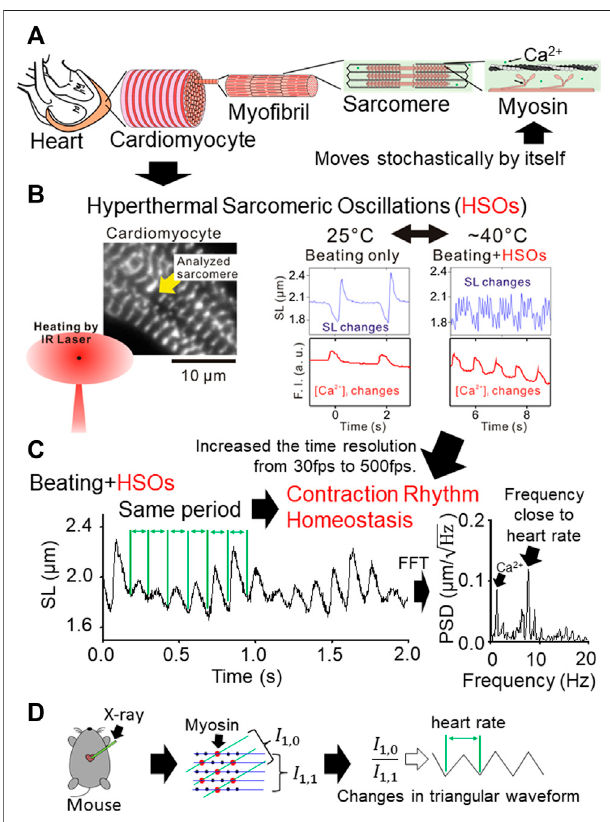
FIGURE 1 |(A) Schematic diagram of the hierarchical structure from the myosin molecule, which can move only stochastically by itself, to the heart, which has a strong heartbeat. (B) Schematic diagram of the features of HSOs revealed in 2015 (Shintani et al., 2015). Fluorescence microscope image ofcardiomyocytesthatexpresses α -actinin-AcGFPfusionproteininZ-lineand enables measurement of sarcomere length (left panel). The cardiomyocytes were reversibly warmed by irradiating the vicinity of the cardiomyocytes with infrared rays having a wavelength that water absorbs well (left panel). Time- series changes in sarcomere length and intracellular calcium concentration before and after heating (right panel). By warming, HSOs with a higher frequency than the change in calcium concentration were discovered (right panel). (C) SchematicdiagramofthecharacteristicsofHSOsrevealedin2020 (Shintani et al., 2020). When the time resolution of sarcomere length measurement was improved from 30 fps to 500 fps, it became clear that the period of a sarcomeric oscillation cycle was kept constant even though the waveform of the sarcomeric oscillation changed signi fi cantly with the change in calcium concentration (left panel). The frequency of HSOs was close to the heart rate (right panel). (D) Schematic diagram of a non-invasive real-time measurement of the movement of myocardial contractile protein molecules from the beating heart by synchrotron radiation X-ray diffraction (Pearson et al., 2007). When the sarcomere contracts, the I 0 , 1 / I 1 , 1 value decreases, and when the sarcomere relaxes, the I 0 , 1 / I 1 , 1 value increases.